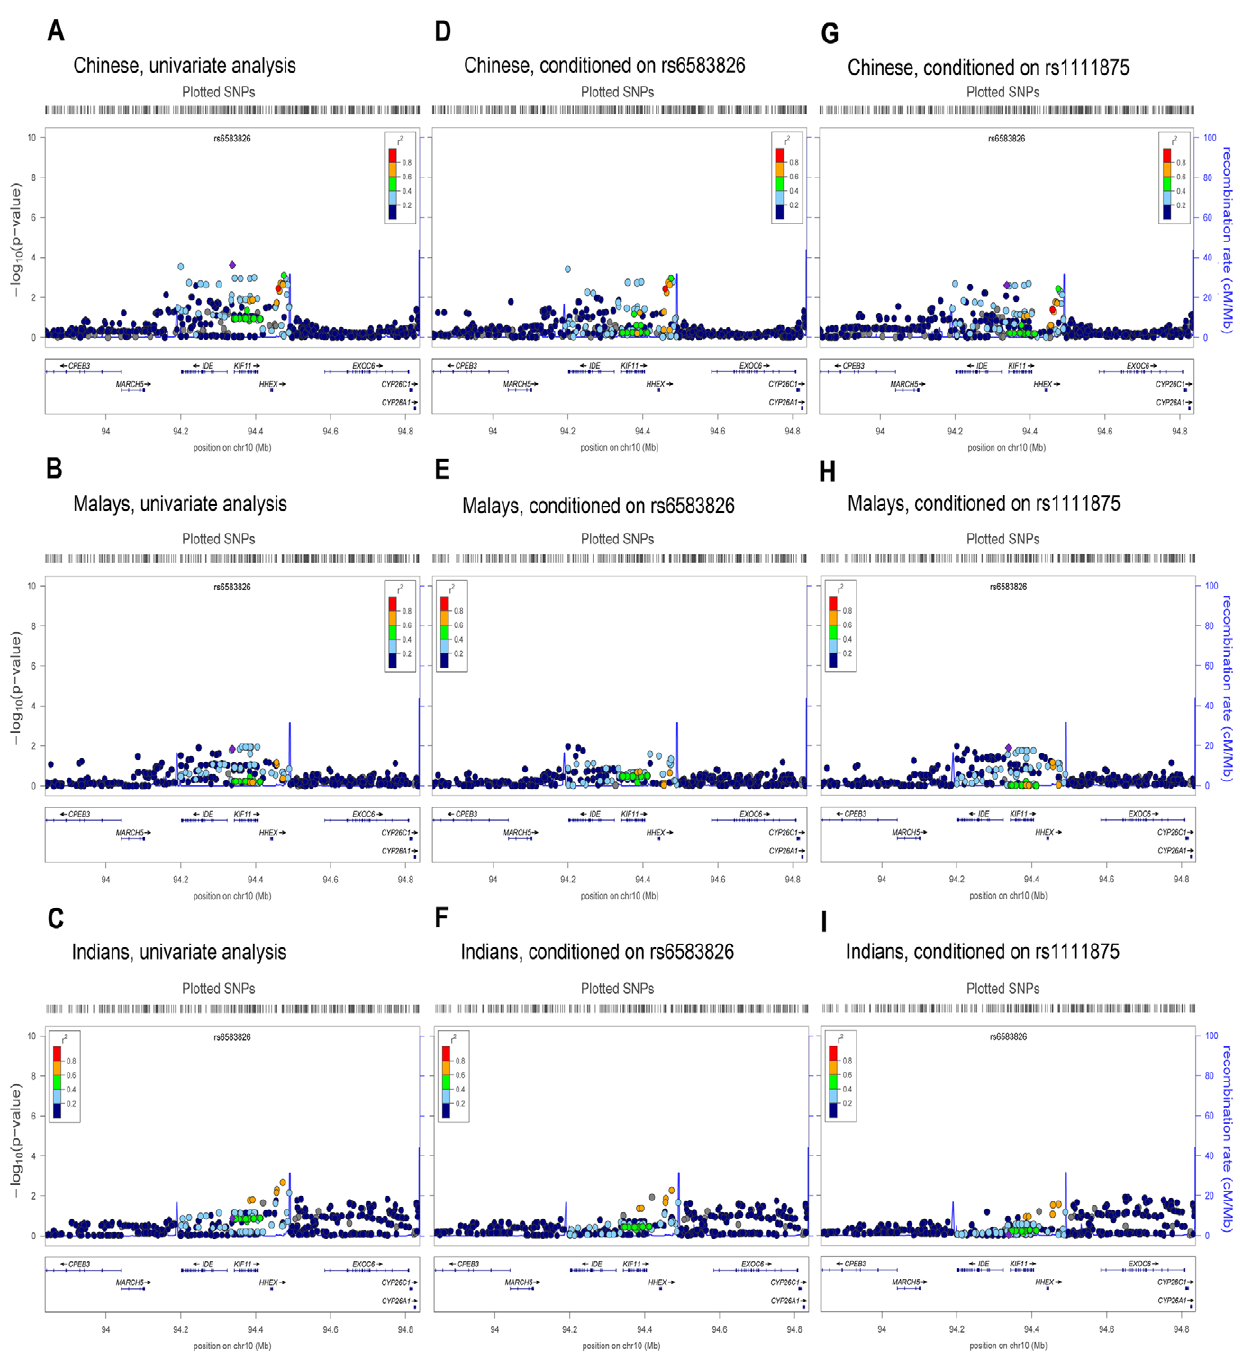
Figure 3. Regional association plots of the index SNP in HHEXX/IDE/KIF11 . For each ethnic group, the univariate analysis regional plot, A) Chinese B) Malays C) Indians, is shown together with analysis conditioned on the index SNP rs6583826, D) Chinese E) Malays, F) Indians, found in meta-analysis across three ethnic groups and established index SNP rs1111875, G) Chinese H) Malays I) Indians, in populations of European ancestry.